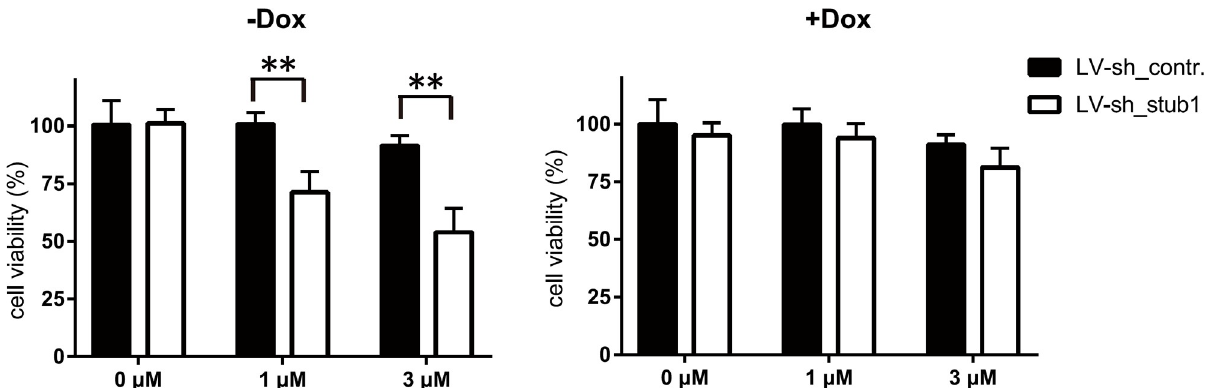
Fig 6. STUB1 protects cells from cytotoxity of Bay41-4109-induced aberrant non-capsid polymers. HepAD38 cells were cultured in the presence (right panel) or absence (left panel) of Dox. Cells were transduced with LV-sh_STUB1 or LV-sh_control. 36 h later, cells were treated with the indicated concentrations of Bay41-4109 for 6 d. A CCK-8 assay was used to quantify cell viability. The error bars indicate ± SD. �� p < 0.01, p value was calculated by unpaired two-tailed Student’s t-test.